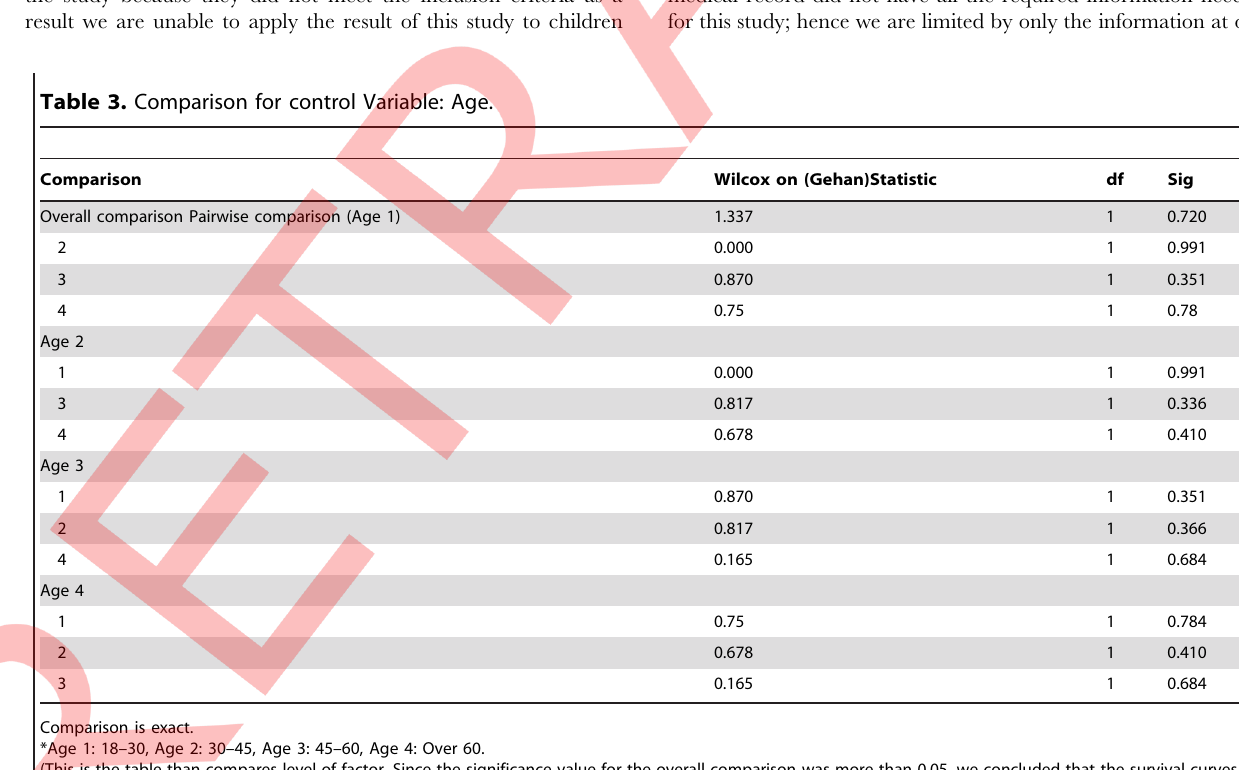
Figure 4. Plot of KM for Age Category.